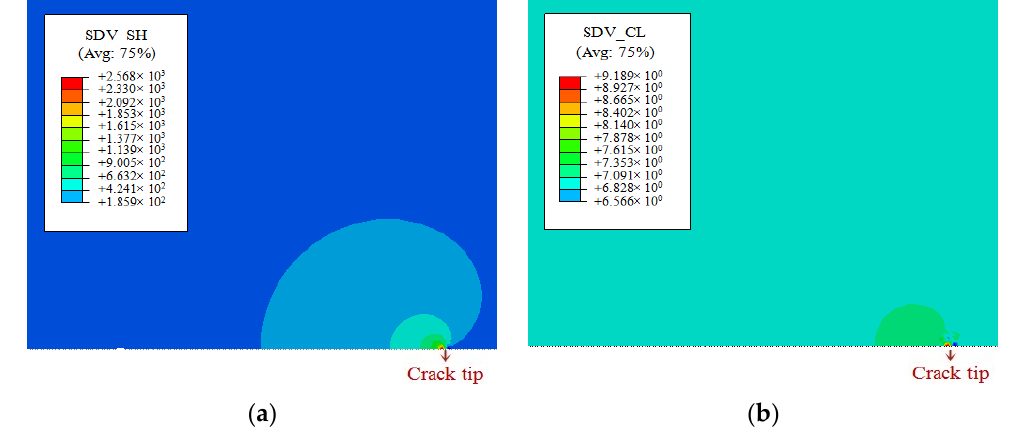
Figure 7. ( a ) Hydrostatic stress and ( b ) hydrogen concentration contours near the crack tip at u = 0.10 mm for 0 C = 7.0 ppm.